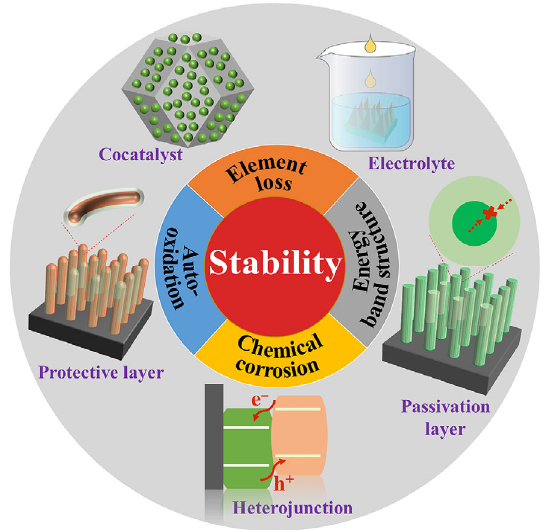
Figure 1 The context diagram of this